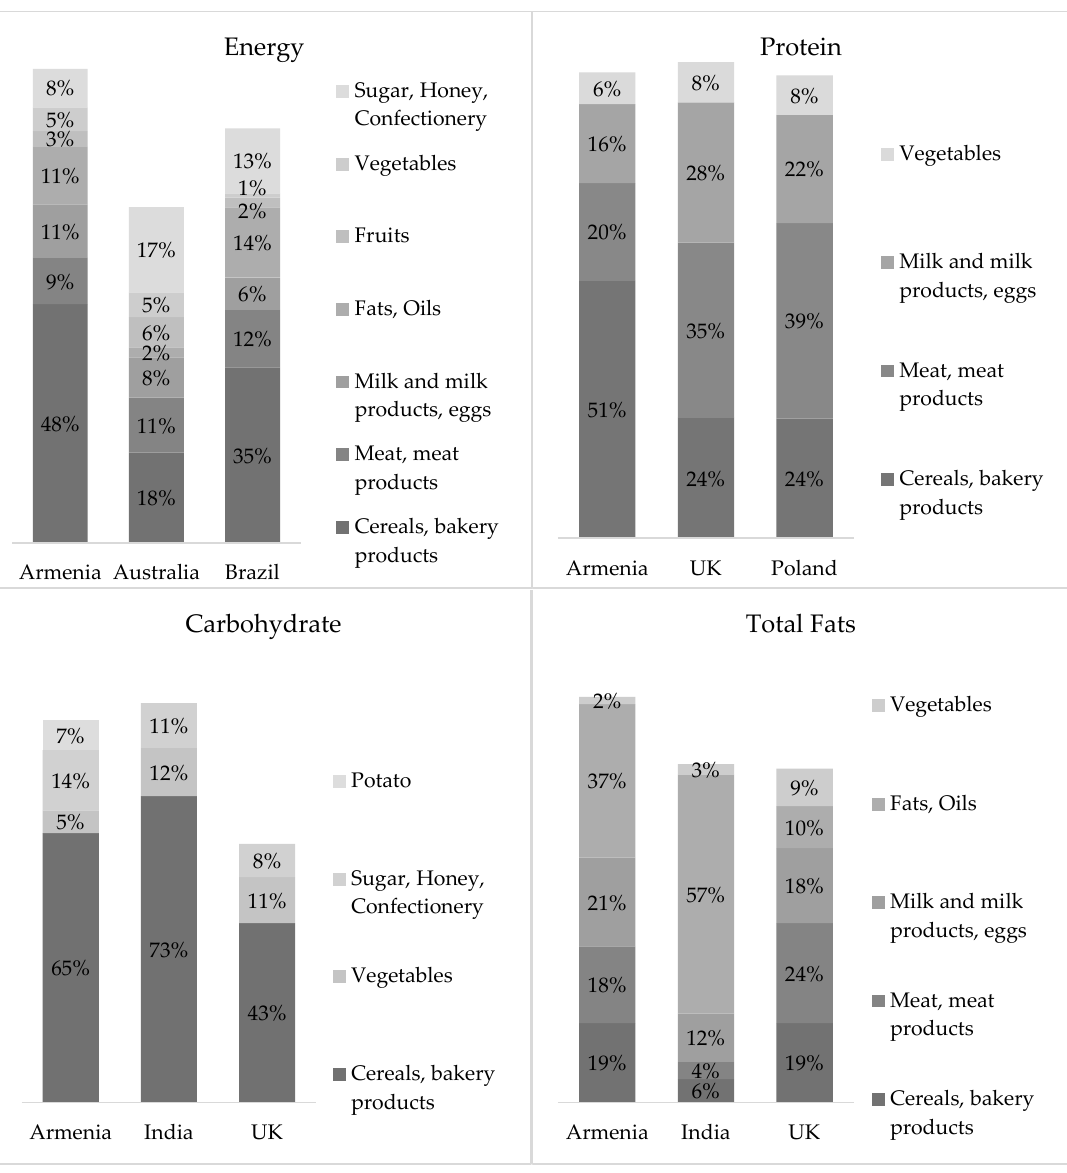
Figure 4. Contribution of food groups to total daily energy and macronutrient intakes in different countries (%).